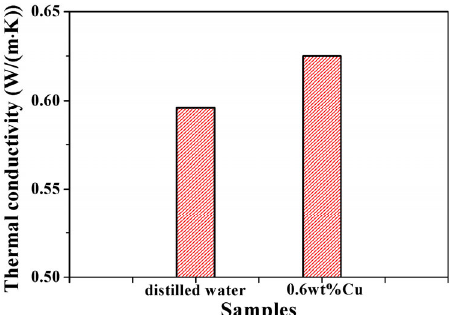
Fig. 8 The thermal conductivity of distilled water and distilled water containing 0.6 wt% as-prepared Cu nanoparticles.